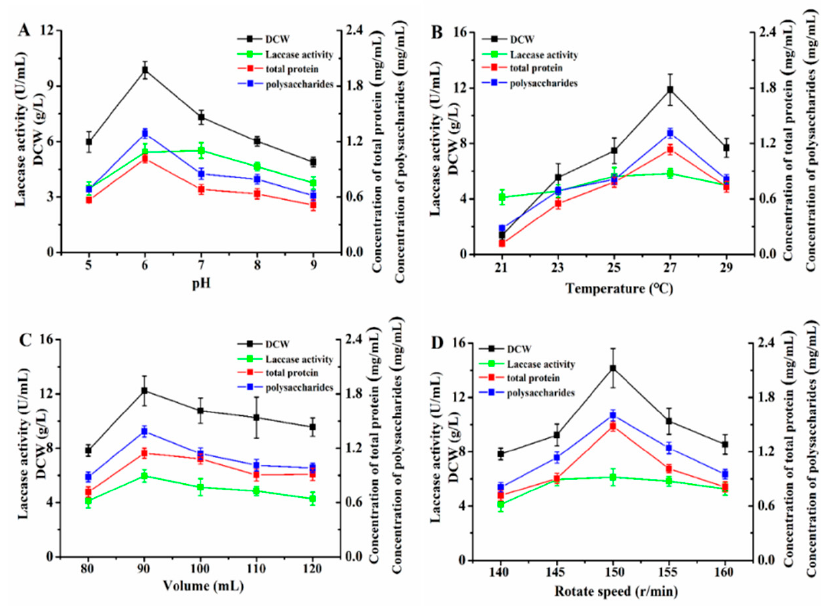
Figure 4. The effect of fermentation parameters on the DCW, laccase activity, total protein, and polysaccharides of P. eryngii -3 in the shake flask. ( A ) pH; ( B ) temperature; ( C ) volume; ( D) rotation speed. Data points are the average of n = 3; error bars represent the standard error of the mean. The samples were harvested at 168 h of fermentation.